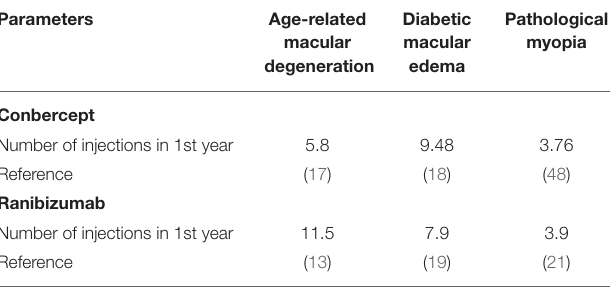
TABLE 5 | Sensitivity analyses about number of injections of conbercept and ranibizumab in randomized controlled trial (RCT) scenario.